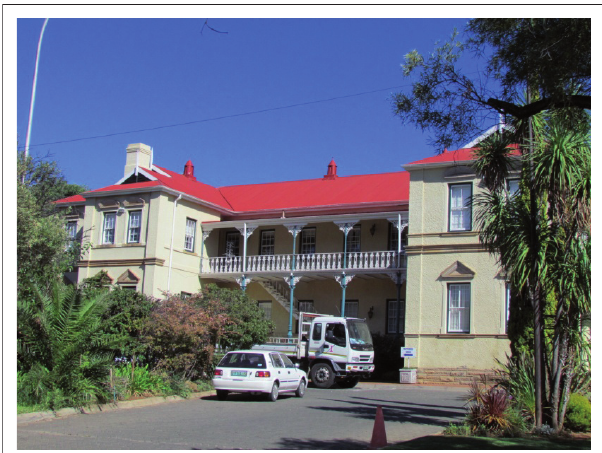
FIGUUR 6: ‘En toe ek die oggend so uit my klas uitstap vir die eerste keer en die rooi rose was daar so voor my tuin, en hulle het so geblom en daai grasperke ... dit was vir my die ongelooflikste oomblik by